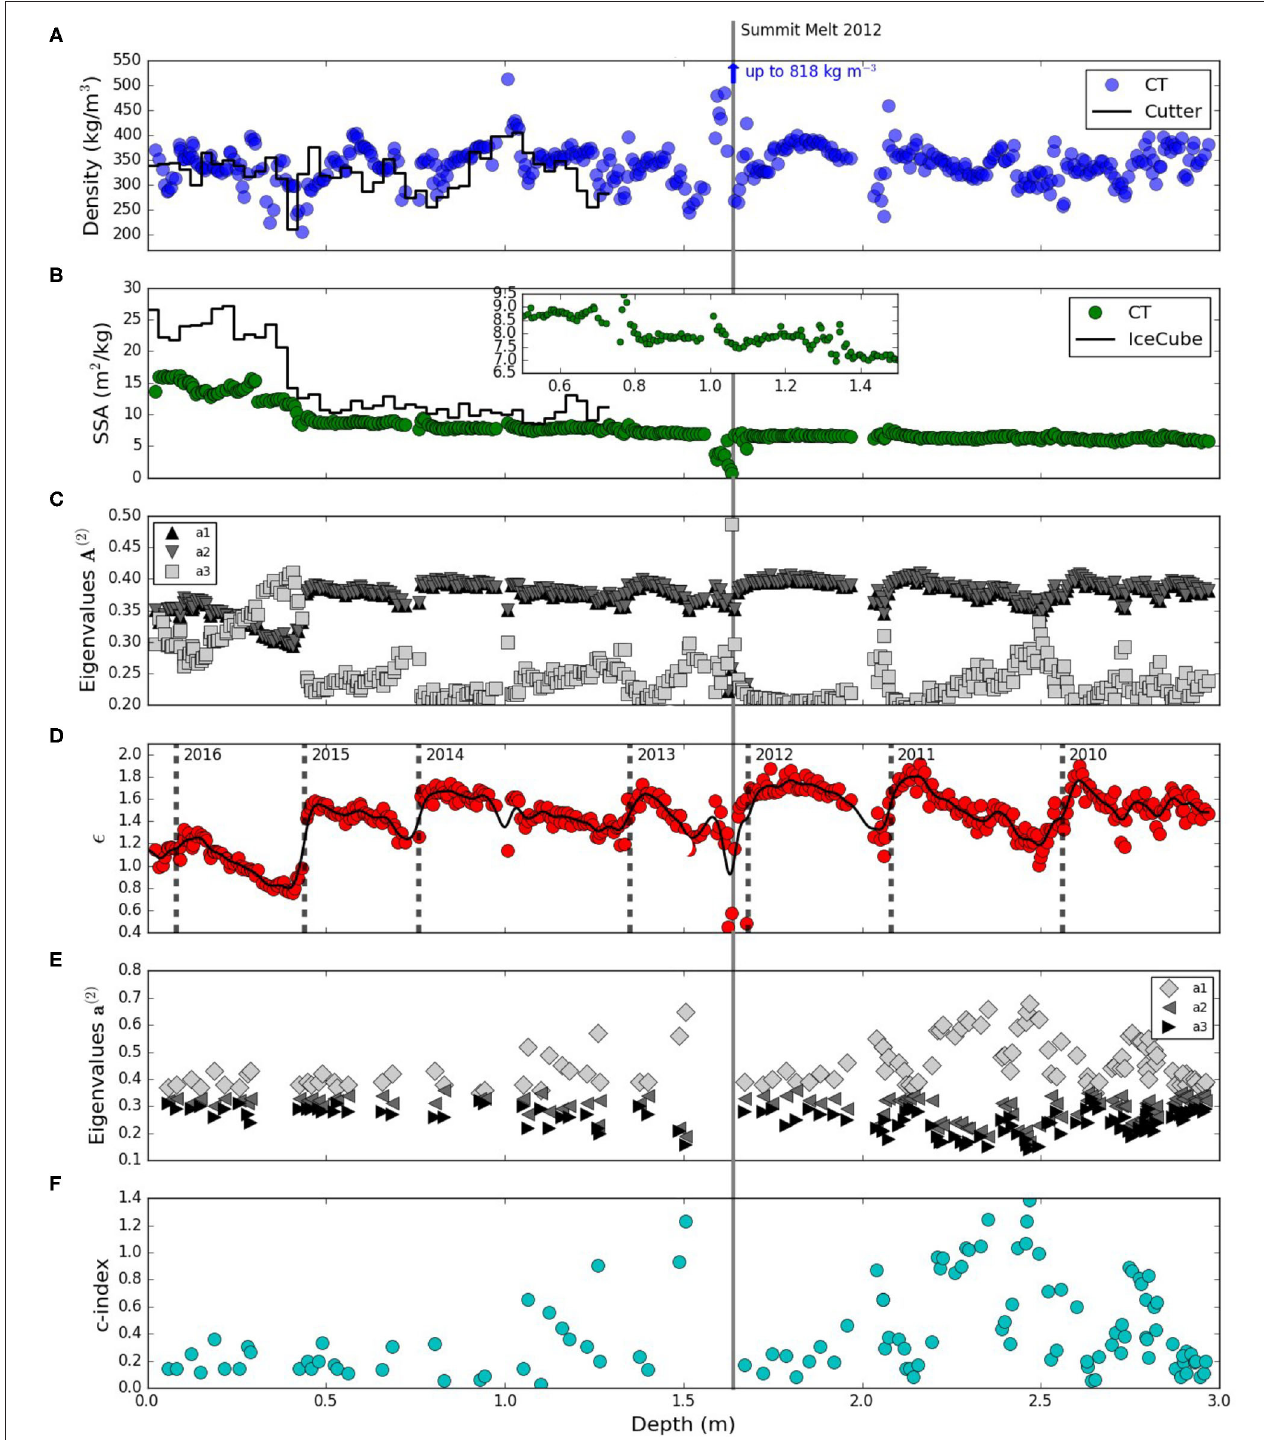
FIGURE 7 | Structural and crystallographic signals extracted from microCT and AITA from the snow profile taken at EastGrip. (A) Density (kg m − 3 ). (B) Specific Surface Area (m 2 kg − 1 ). (C) Eigenvalues of the structural fabric tensor A (2) . (D) Ratio of the vertical and horizontal correlation lengths. (E) Eigenvalues of the second order orientation tensor a (2) . (F) Cluster index n C . The figure is complemented by a marker for the 2012 melt event and several anisotropy markers [2016-2011 in (D) ] that correspond to the early summer season of the respective year (for details cf. text).